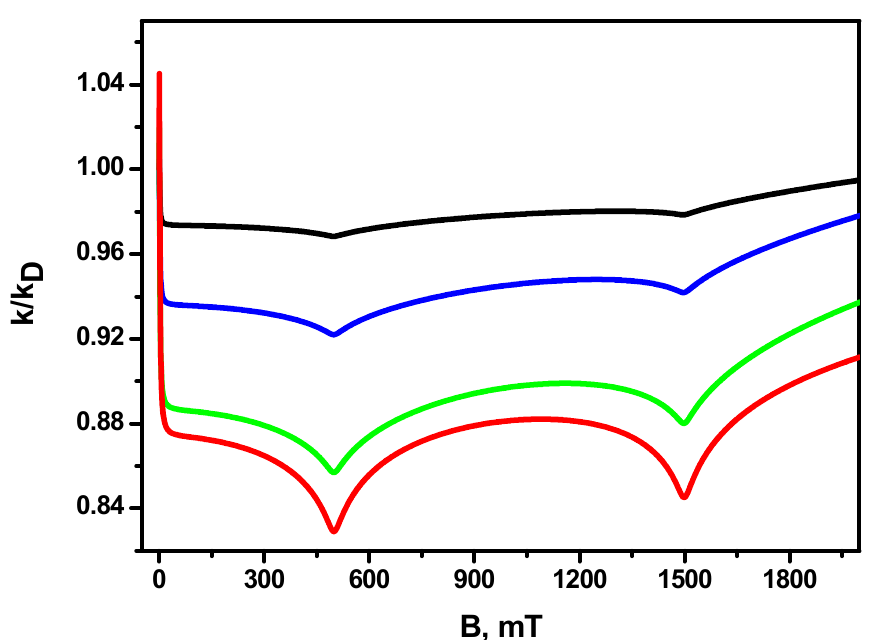
(cid:3118) (cid:3118) , blue line 𝐷 = 2.0 ∙ 10 (cid:2879)(cid:2874) (cid:2913)(cid:2923) , black line 𝐷 = 2.0 ∙ , blue line D = 2.0 · 10 − 6 cm 2 , black line s s (cid:2929) (cid:2929)